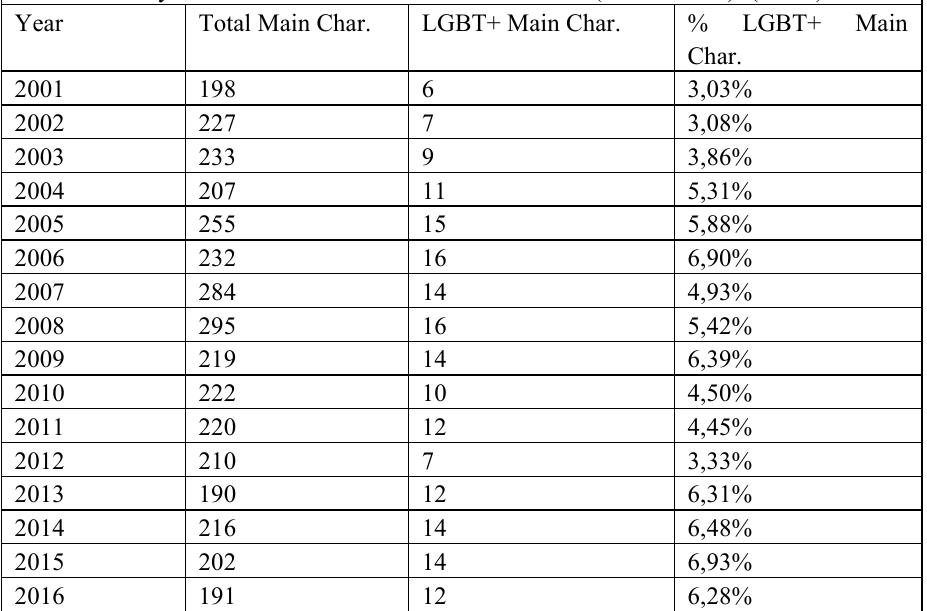
Table 2. Yearly relative share of LGBT+ main characters (2001 – 2016) 3 (N=57) Year Total Main Char. LGBT+ Main Char. % LGBT+ Main